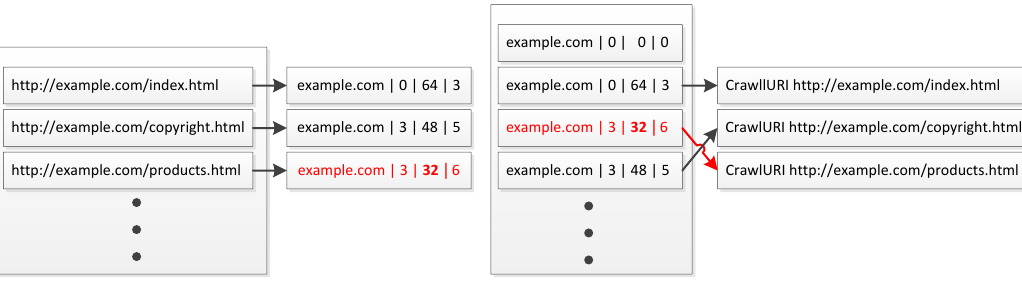
Figure 7. Example of updating the priority of a URL in the frontier of Adaptive